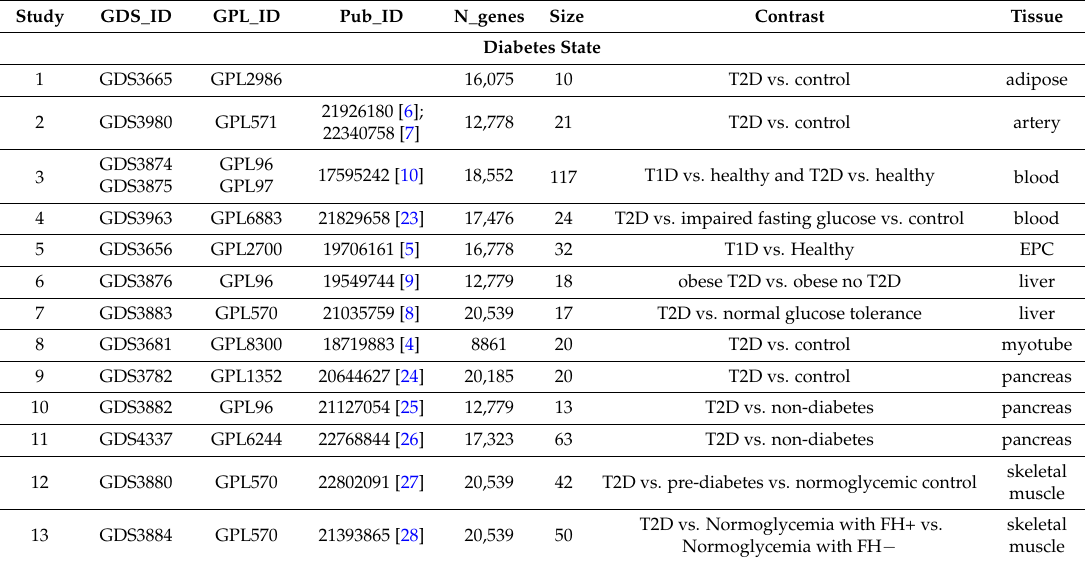
Table 1. Characteristics of the gene expression